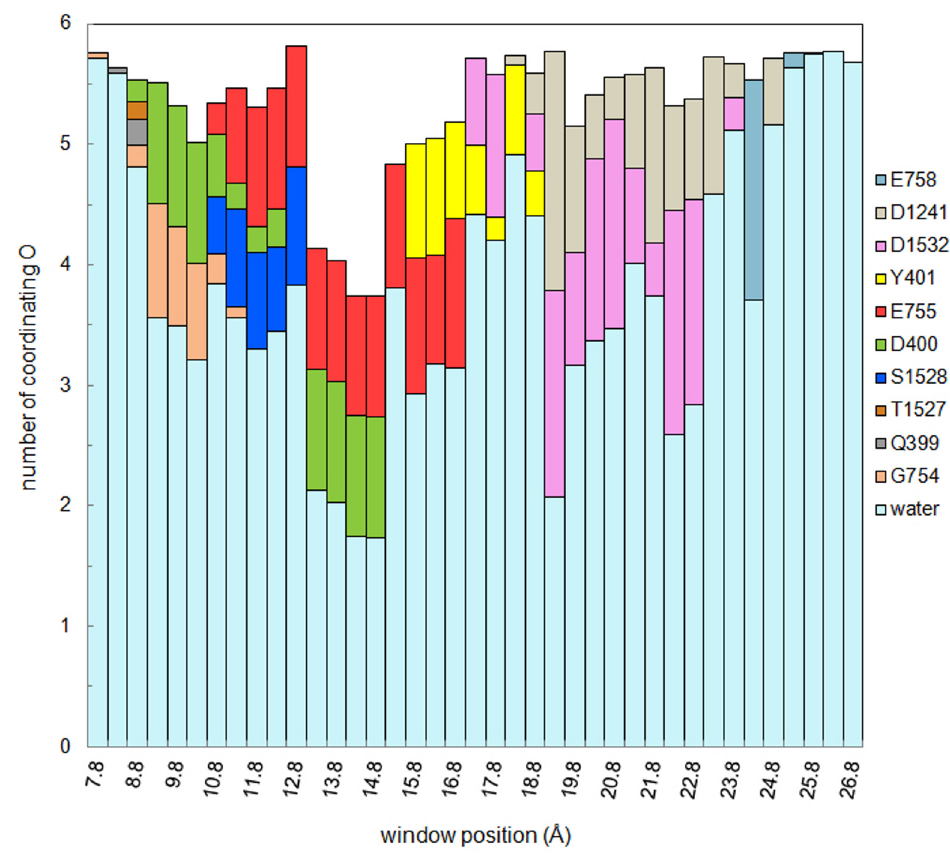
Fig 8. Average number of oxygen atoms coordinating the Na + ion in the Na V 1.4 pore. The results are obtained using 2 – 6 ns of the PMF data from each umbrella sampling window. Contribution from each residue and water molecules are shown with different